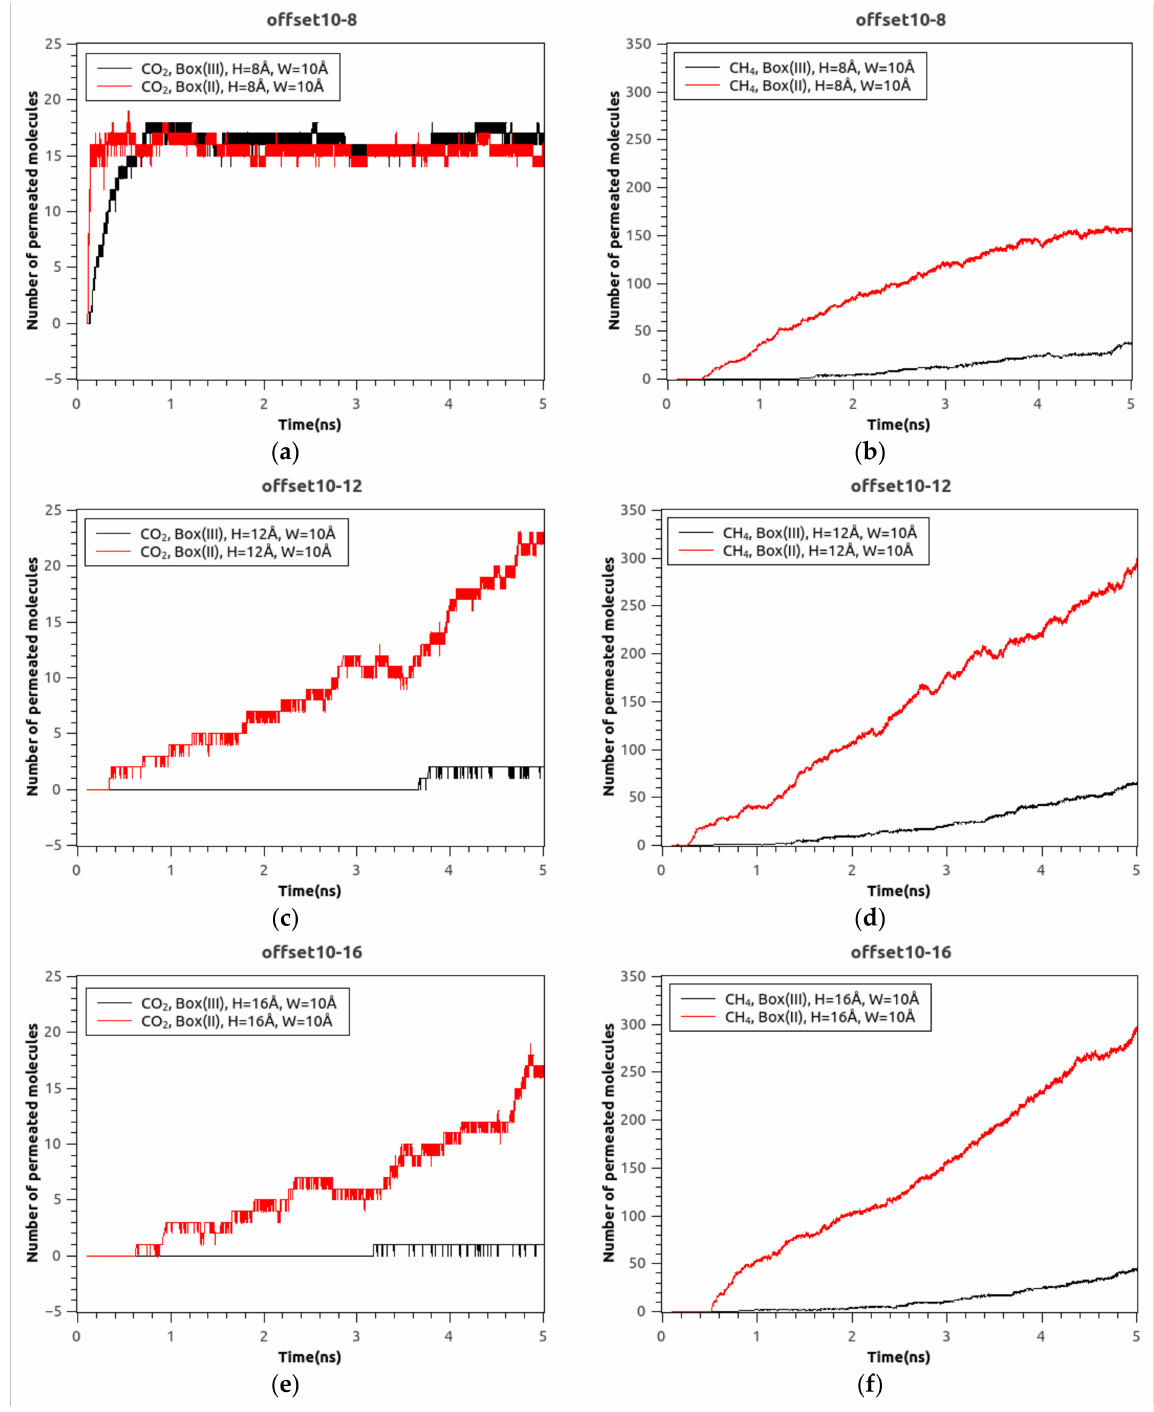
Figure 5. Time-varying number of molecules in the chamber(II) and chamber(III) permeated across the two-stage bilayer NPG for the configuration with W = 10 Å of ( a ) CO 2 , H = 8 Å ( b ) CH 4 , H = 8 Å ( c ) CO 2 , H = 12 Å ( d ) CH 4 , H = 12 Å ( e ) CO 2 , H = 16 Å ( f ) CH 4 , H = 16